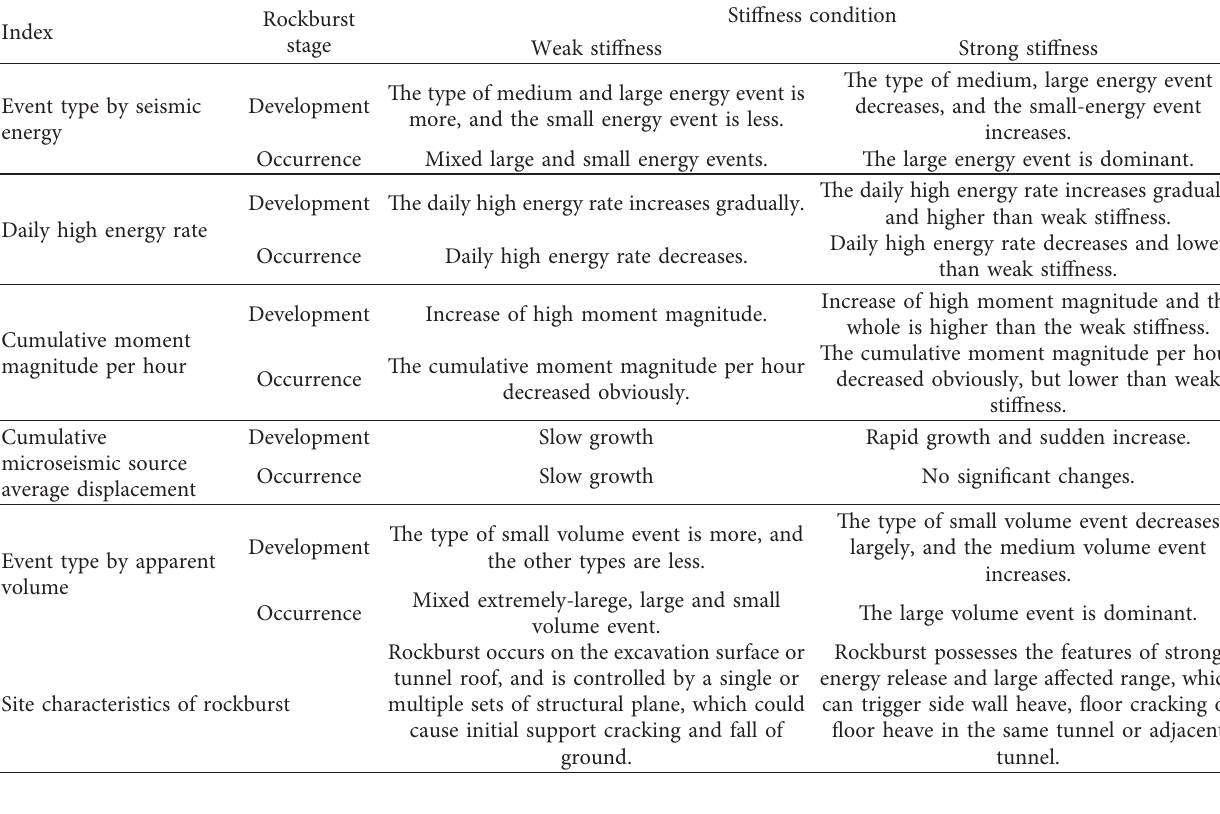
Table 4: Evolution of rockburst index with the strengthening of support stiffness.